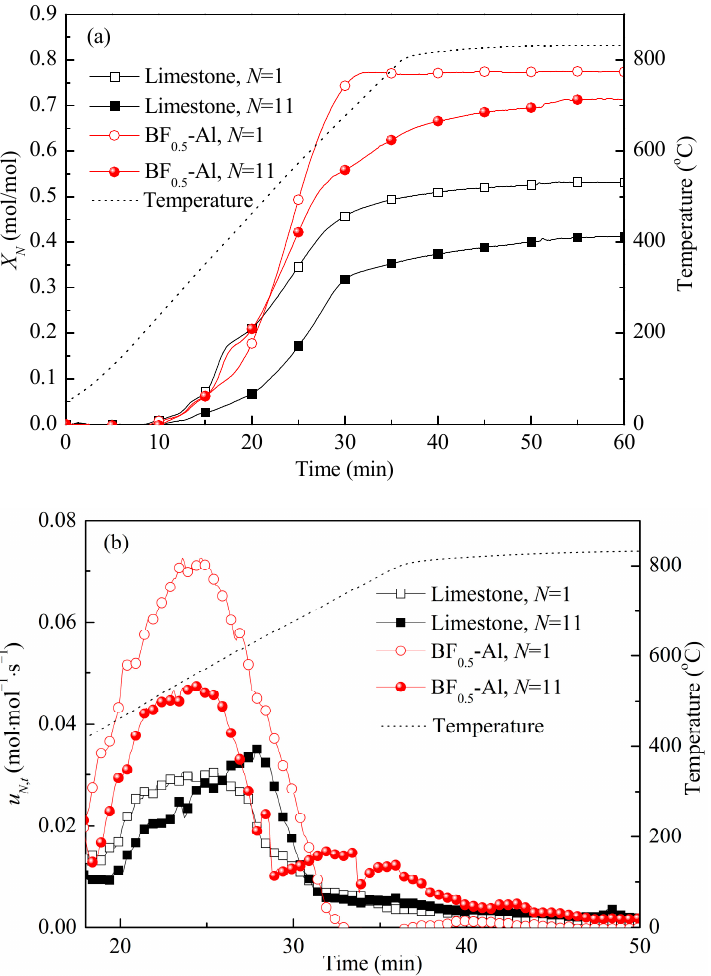
Figure 6. Carbonation kinetics in the 1st and 11th cycles: ( a ) the time evolution of carbonation conversion; ( b ) the time evolution of carbonation rate.